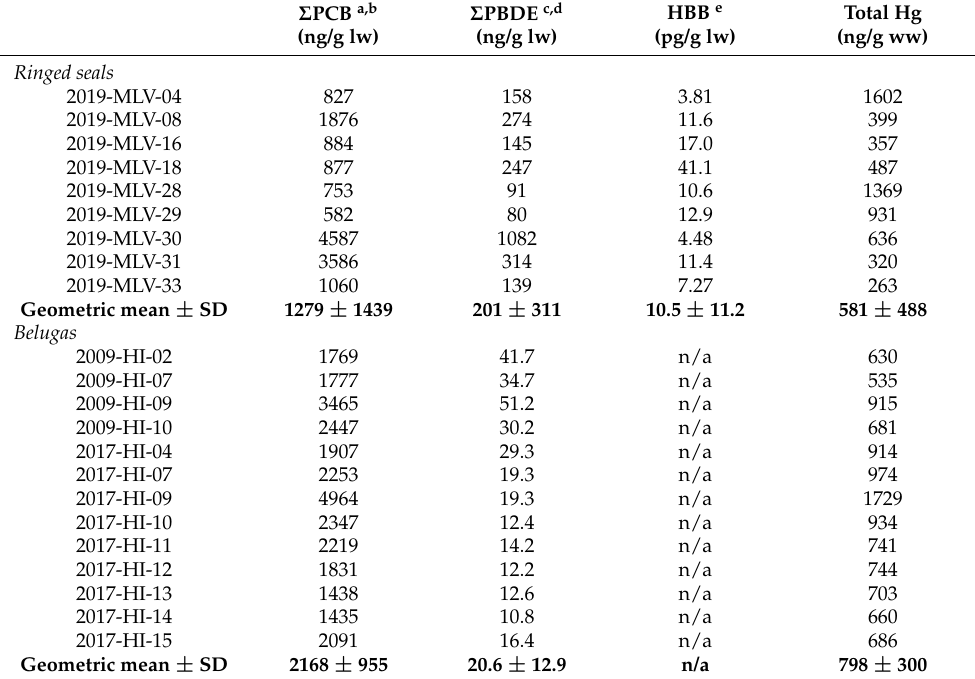
Table 2. Blubber concentrations of ∑ polychlorinated biphenyls (PCBs), ∑ polybrominated diphenyl ethers (PBDEs), hexabromobenzene (HBB) and muscle concentrations of total mercury (Hg) in adult male ringed seals ( n = 9) from Lake Melville, and adult male belugas ( n = 13) from the Eastern Beaufort Sea population. Σ PBDE c,d Σ PCB a,b (ng/g (ng/g lw)